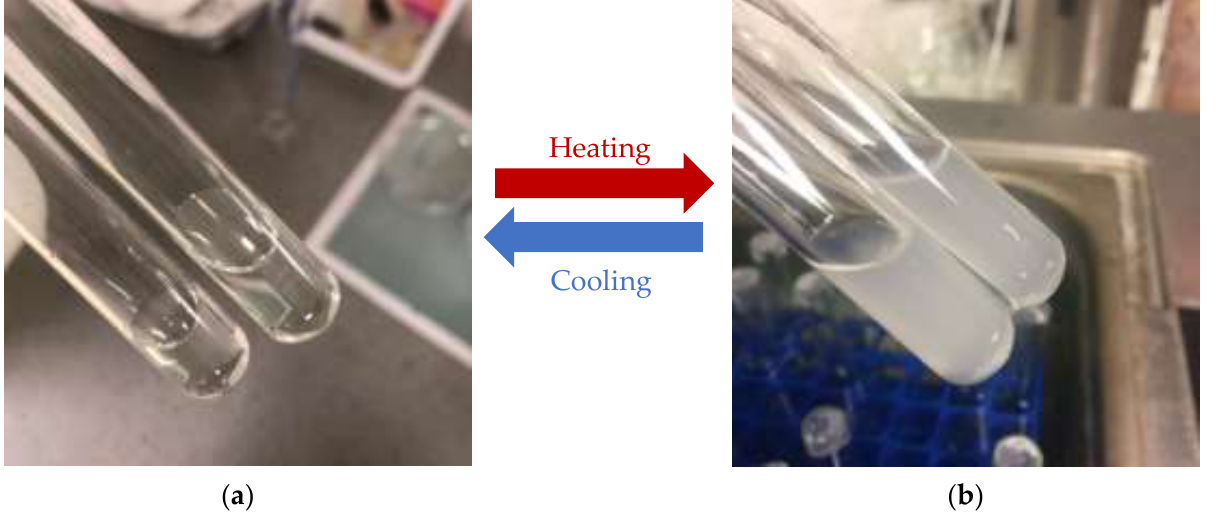
Figure 6. As the temperature rises or falls, the state of the aqueous solution switches between transparent and opaque. ( a ) The state of the aqueous solution of control samples C1 before heating; ( b ) the state of aqueous solution of control samples C1 after heating.